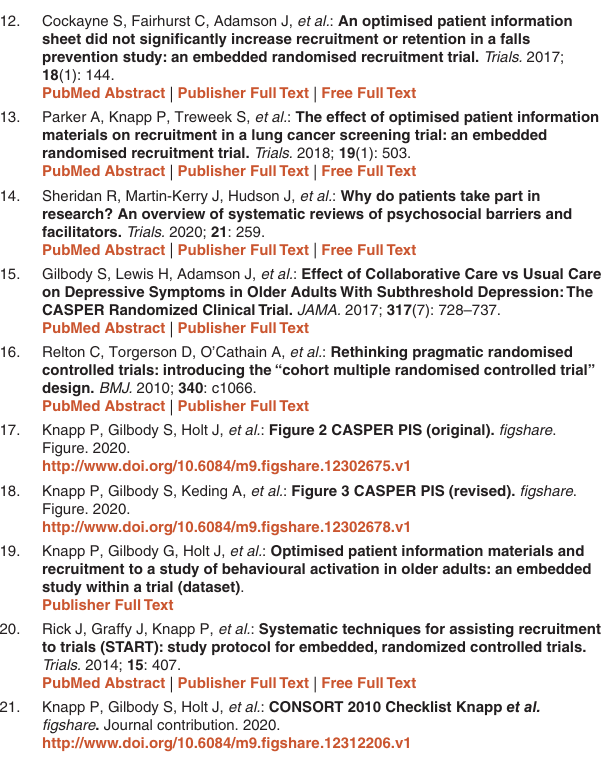
Figshare: Figure 2 CASPER PIS (original). https://doi.org/10.6084/ m9.figshare.12302675 17 .